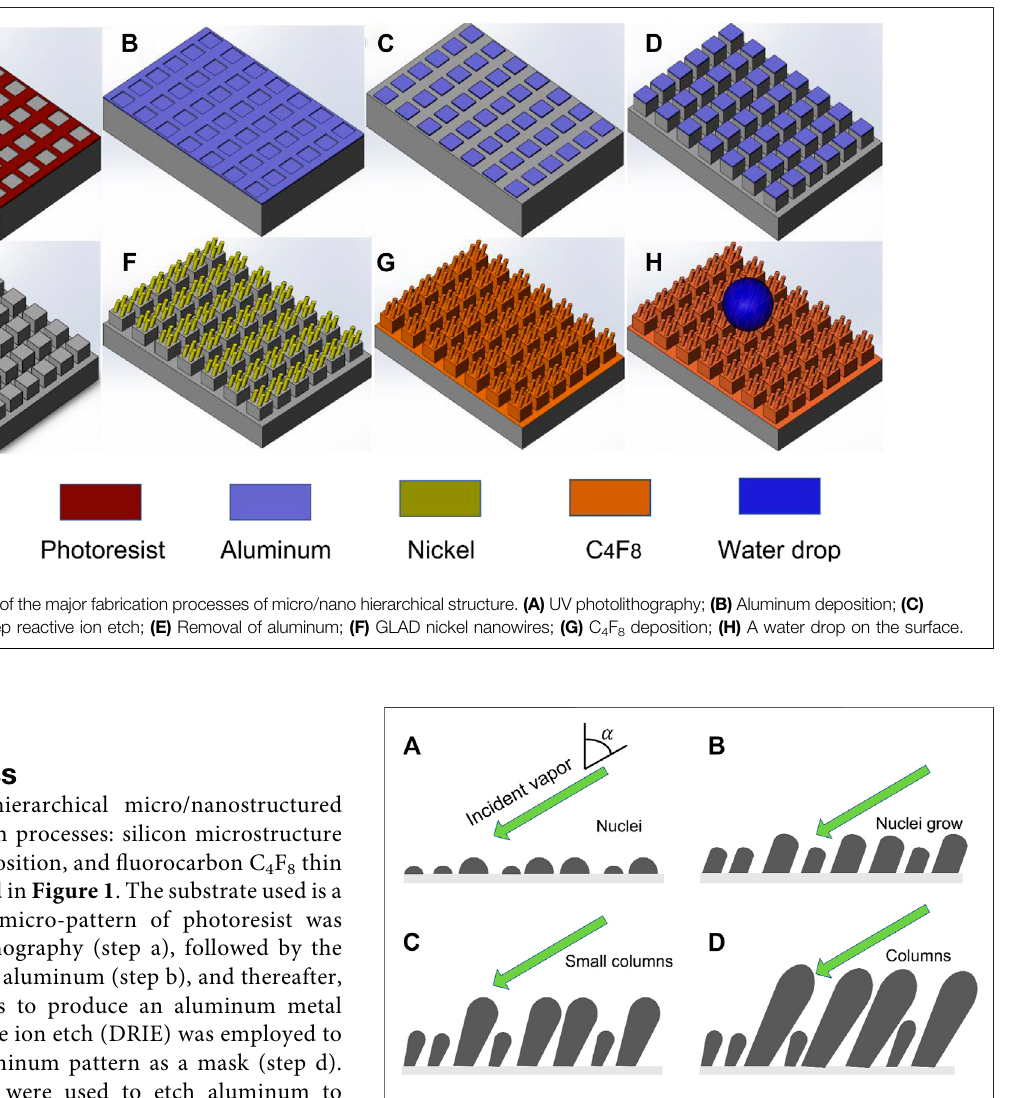
FIGURE 2 | Schematic view of GLAD nanowires growth. (A) Vapor fl ux at an angle α produces a random distribution of nuclei on a substrate surface, (B) nuclei grow; (C) the nuclei develop into columns, some smaller columns were shadowed and stopped their growth; (D) columns growth and the further growth is restricted to the top of